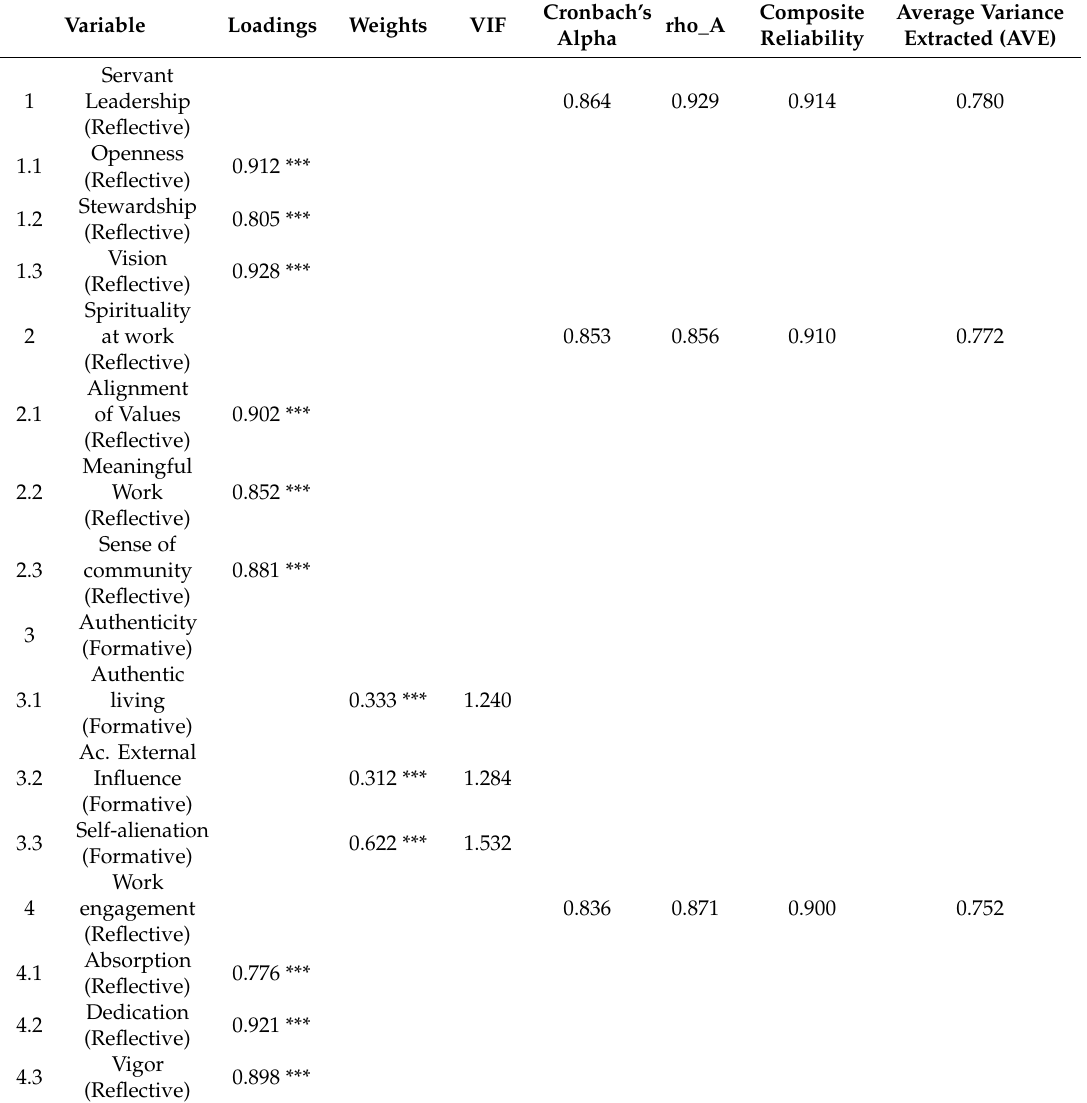
Table 3. Measurement model. Reliability and convergent validity.